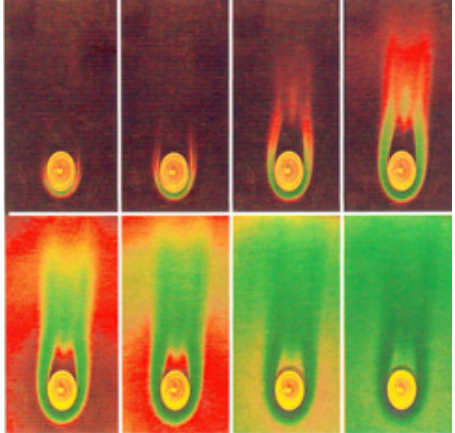
Figure 7. An example of visualization of a non-stationary temperature field on a flat surface around a cylinder surrounded by air at 45 °C.